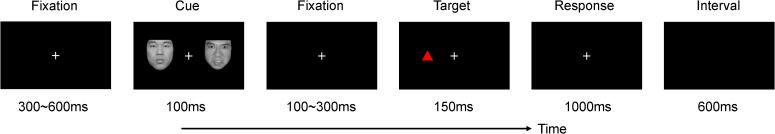
Schematic representation of experimental procedure. Each trial contained a cue (an angry/fear/happy face in one side of the screen and a neutral face in the other side) and a target stimulus (a red/green triangle that might be upper or lower). Congruent (the emotional face and the target appeared at the same position) and incongruent (the emotional face and the target appeared at different positions) trials were appeared in random order with equal probability (50% each). Participants were required to judge the target position by pressing “f” (left) or “j” (right), and they were instructed to respond only one kind of triangle (the upper or the lower, counterbalanced across subjects) but ignore its color. Importantly, we used a different percent of responding trials in our EEG (go trials, 10%, no-go trials, 90%) and behavioral tasks (go trials, 50%, no-go trials, 50%) to study the spatial orienting in EEG task.